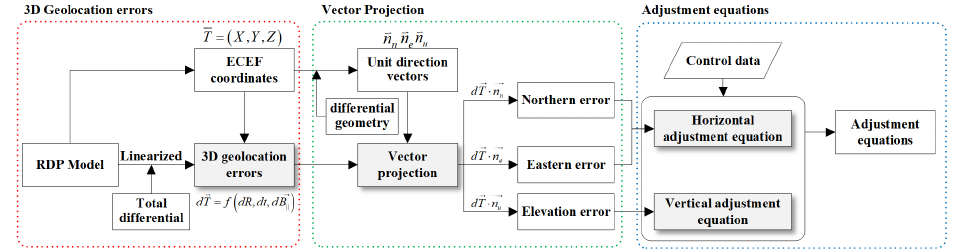
Figure 5. The derivation process of the proposed method consists of three steps, including calculating the three-dimensional geolocation errors caused by InSAR parameters, calculating the projection of geolocation error vectors, and obtaining adjustment